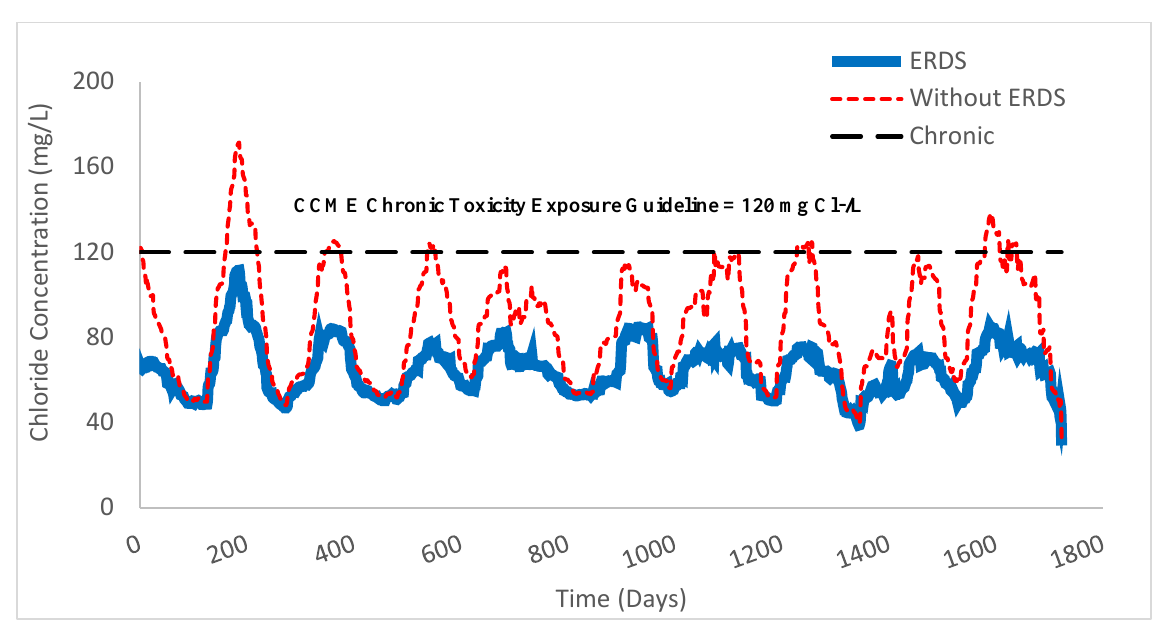
Figure 10. Average monthly chloride concentration in the receiving stream with and without ERDS for ten winter seasons. Table 2. Summary of ERDS size and orifice diameter for each